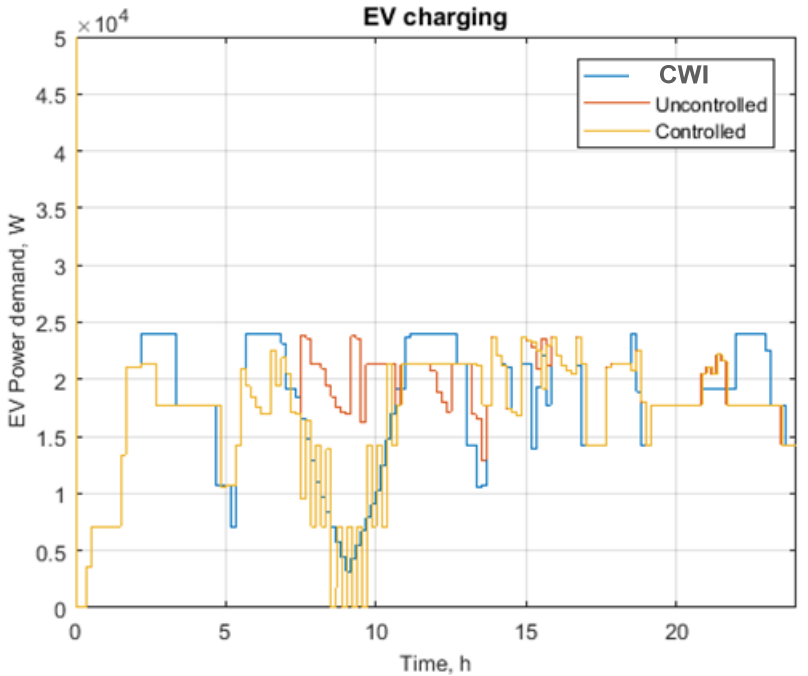
Figure 15. CS charging based on various charging algorithms.